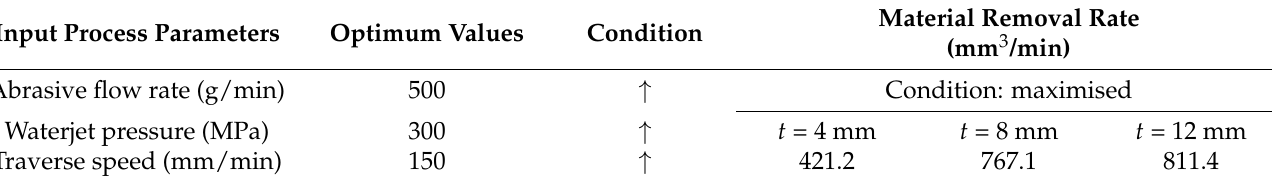
Table 10. Optimum parameters for material removal rate.